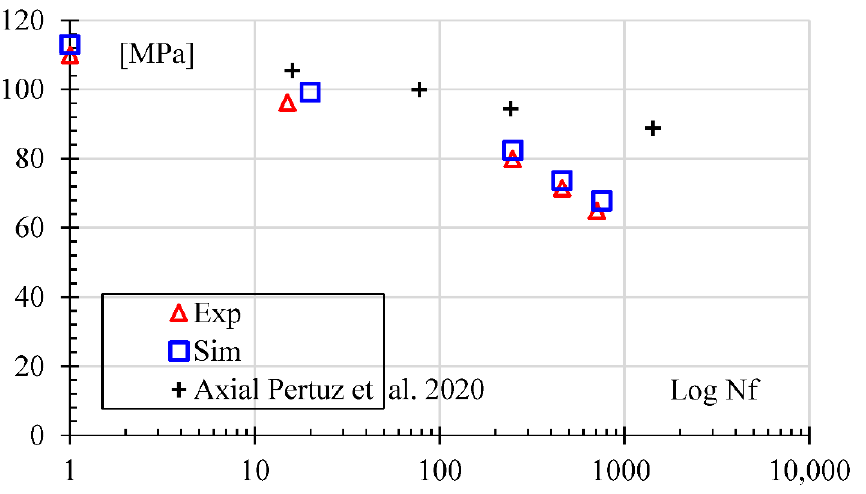
Figure 12. Stress-life curve for experimental and simulation results [15].